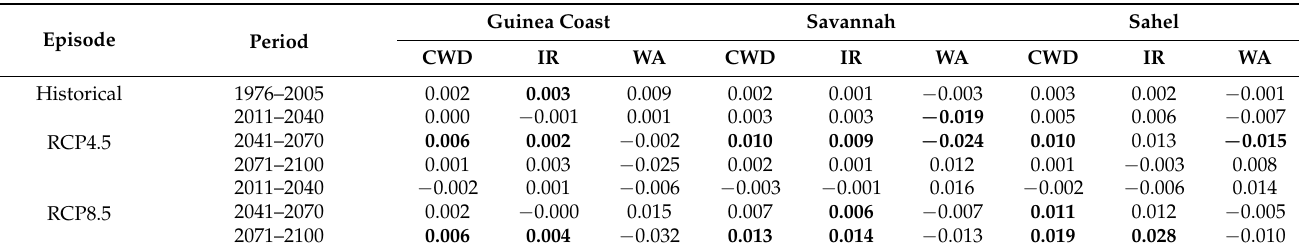
Table 2. Summary of historical and projected trends in CWD, IR, and WA (mm/day/year) averaged over the three climatic zones;Guinea Coast, Savannah, and Sahel. Bold values depict significant trends at 0.05